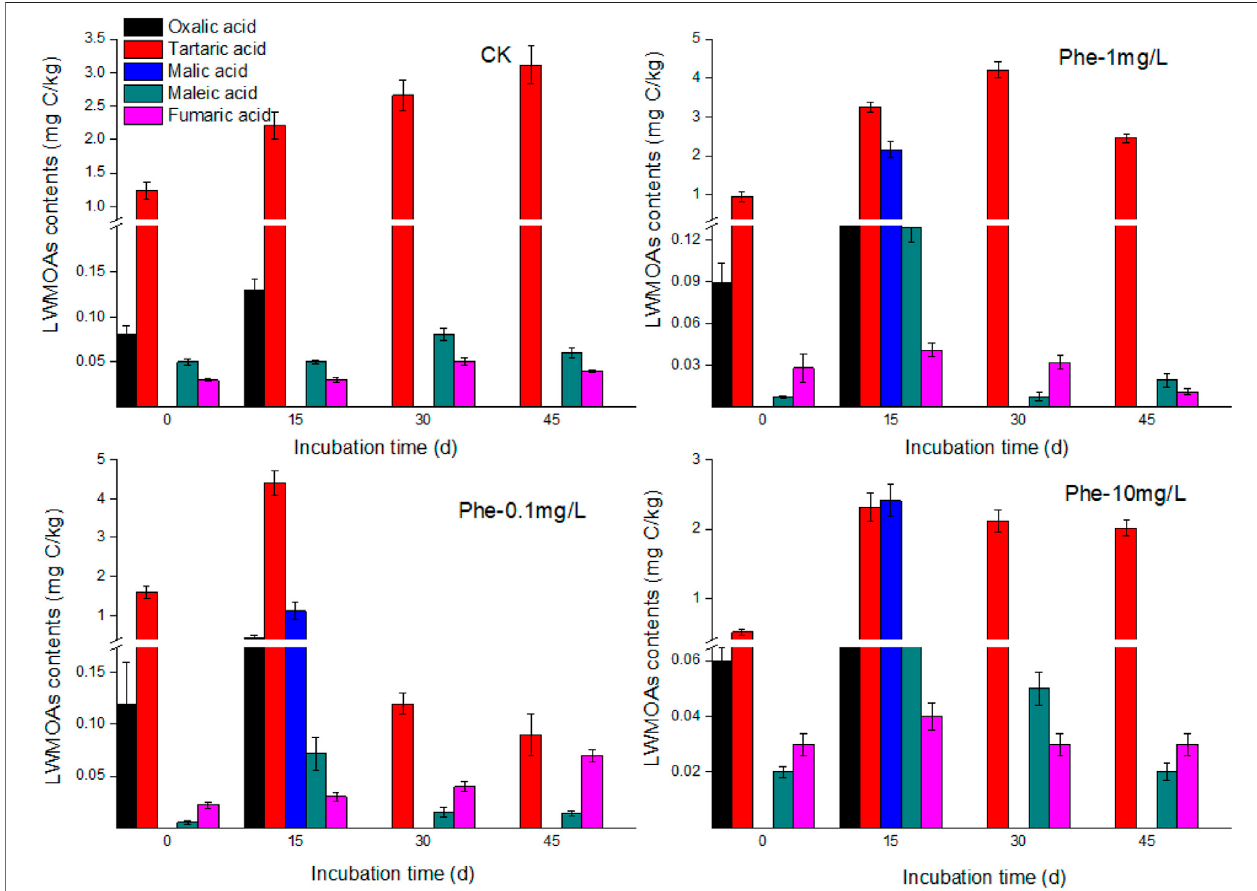
FIGURE 4 | The change of LWMOAs in root exudates under Phe